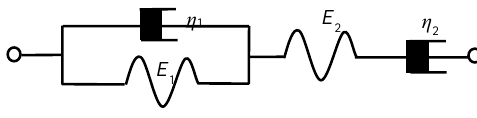
Figure 10. Burgers’ model.